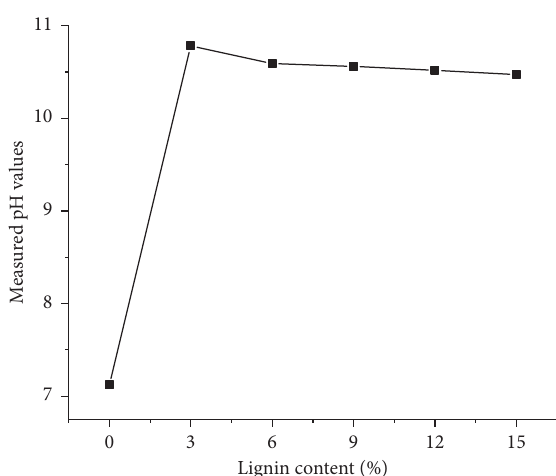
Figure 6: The SEM and EDS test.